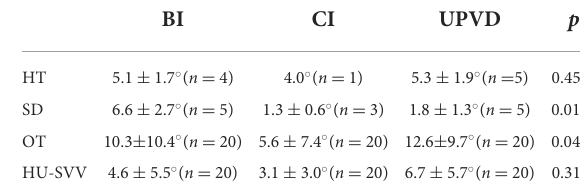
TABLE 2 Test results of components of OTR in three patient